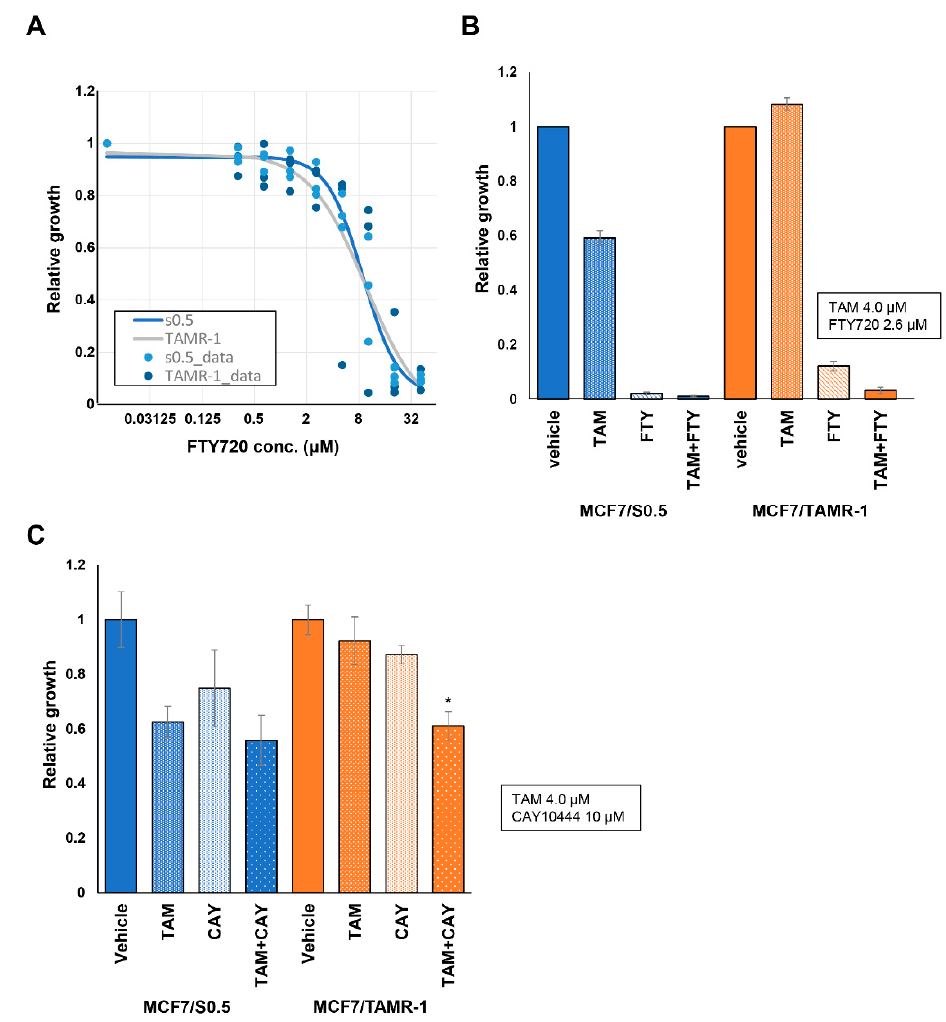
Figure 4. Effect of FTY720 on the estrogen receptor (ER)-positive breast cancer cell line, MCF-7, with or without hormone therapy resistance. Effects of different concentrations of FTY720 on the viability of wildtype MCF-7 cells (MCF-7/S0.5) and tamoxifen-resistant MCF-7 cells (MCF-7/TAMR-1) were assessed using WST-8 assay ( A ). The effect of tamoxifen (TAM), FTY720, and both TAM and FTY720 on MCF-7/S0.5 and MCF-7/TAMR-1 were assessed ( B ). The effects of tamoxifen (TAM), and a selective antagonist for S1PR3, CAY10444 (CAY), on MCF-7/S0.5 and MCF-7/TAMR-1 growth were assessed individually and in combination (* p = 0.0017 vs. TAM, p = 0.012 vs. CAY for MCF-7/TAMR- 1) ( C ). FPKM, fragments per kilobase of transcript per million mapped reads; TAM, tamoxifen; FTY, FTY720; CAY,